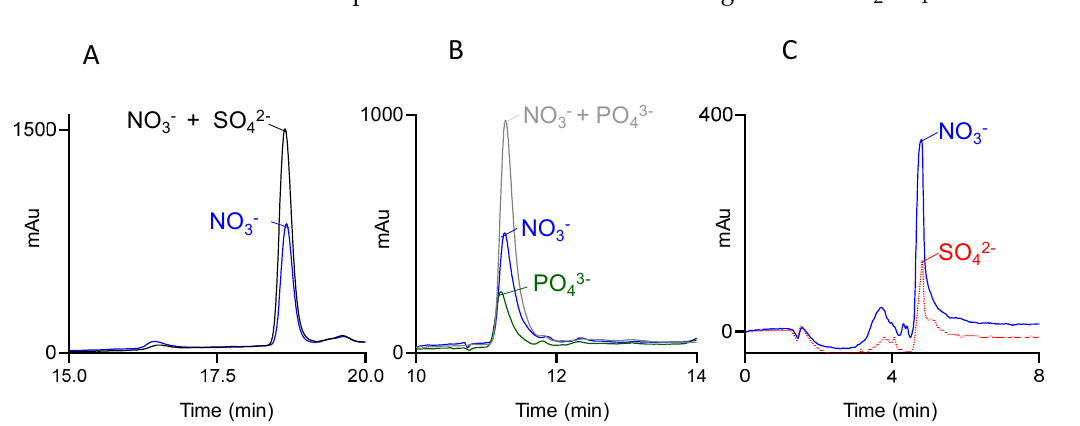
Figure 1. Chromatograms obtained by the IP − CapLC method for the standard solutions, using the three ion pairing agents tested: ( A ) TBH − OH (1 mg/L nitrate and 0.5 mg/L Nitrate + 0.5 mg/L Sulfate), ( B ) TBH − Cl (1 mg/L Nitrate, 0.5 mg/L Nitrate + 0.5 mg/L Phosphate and 0.25 mg/L Phosphate)